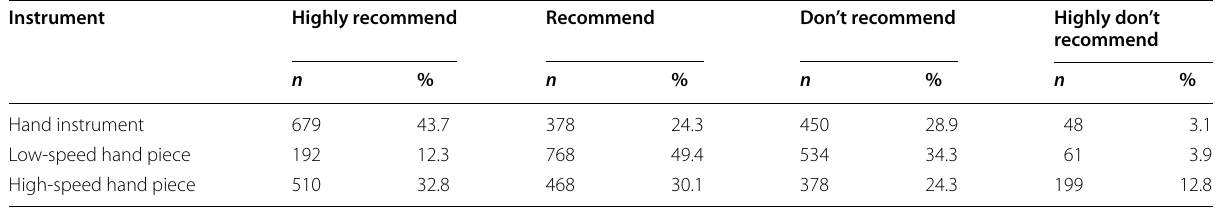
Table 4 Frequencies ( n ) and percentages (%) for answers regarding instruments used during emergency dental treatment during COVID-19 pandemic